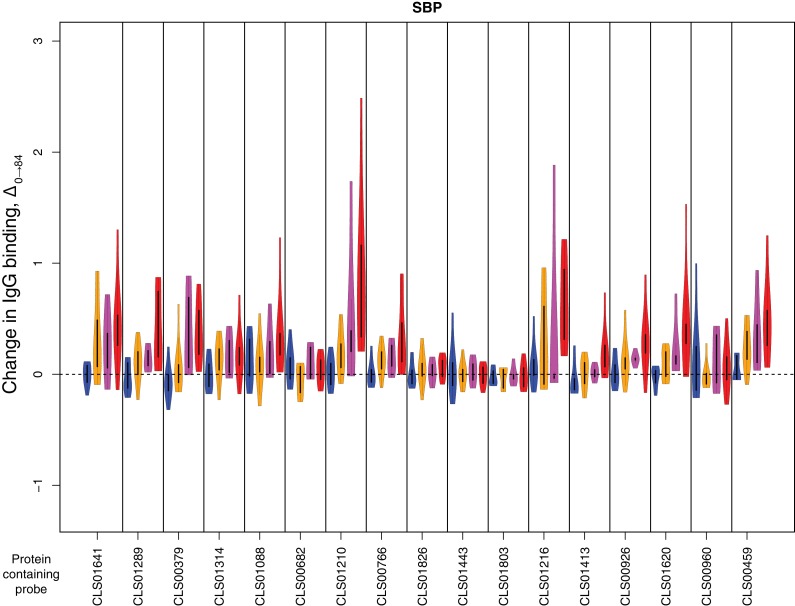
Change in IgG binding during the trial for solute- binding proteins defined as antibody-binding targets on the basis of high pre-vaccination IgG binding.In each plot, vertical bars separate data for different probes. The protein to which the probe corresponds is labelled at the bottom of the graph. The four violin plots show Δ0→84 for each of the four cohorts: placebo in blue, cohort one in orange, cohort two in pink, and cohort three in red. Only data from the 29 individuals for whom samples were available from the start and end of the trial were used.